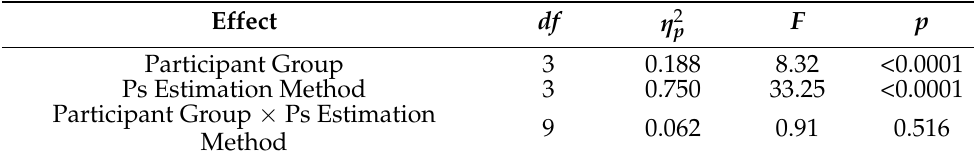
Table 5. Results of the two-way analysis of variance on the root-mean-square error in subglottal pressure (Ps) estimation to determine the main effects of and interactions between the participant group and estimation